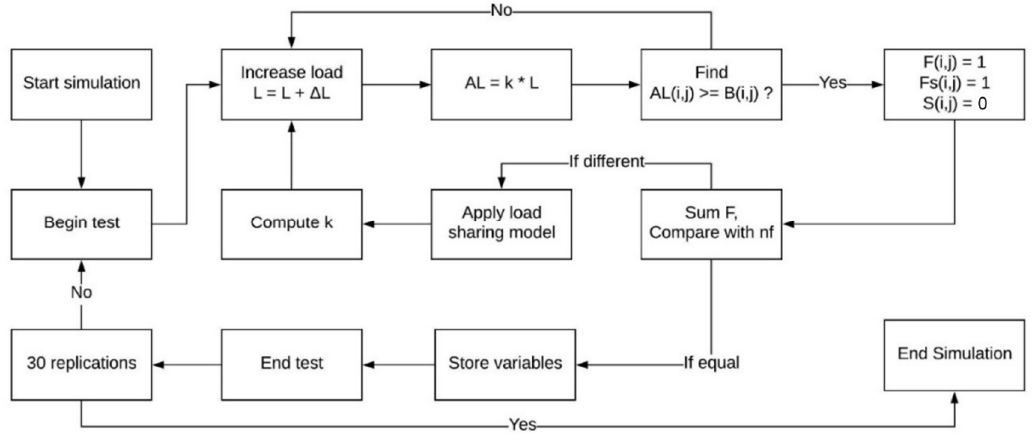
Figure 3. Simulation Process Flow Chart.